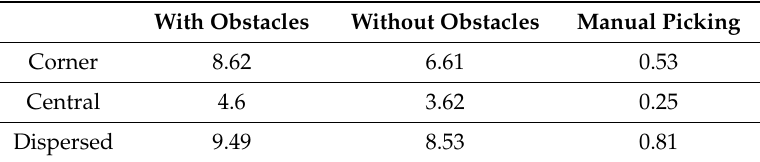
Figure 15. Snapshot of the movement of the robot: egg tracking ( top ) and avoidance of the cardboard chickens used as obstacles ( bottom ). Table 3. Egg collection times (min) for di ff erent egg